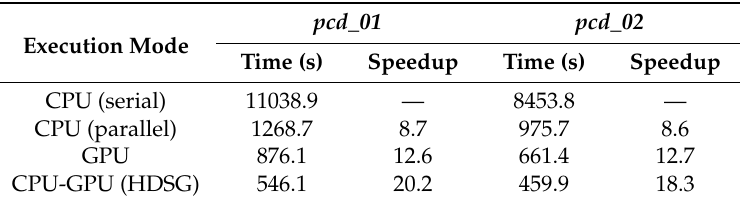
( d ) Figure 9. GPU interpolation time under different decomposition granularities. ( a ) pcd_01 on hpc_01; ( b ) pcd_02 on hpc_01; ( c ) pcd_01 on hpc_02; ( d ) pcd_02 on hpc_02.